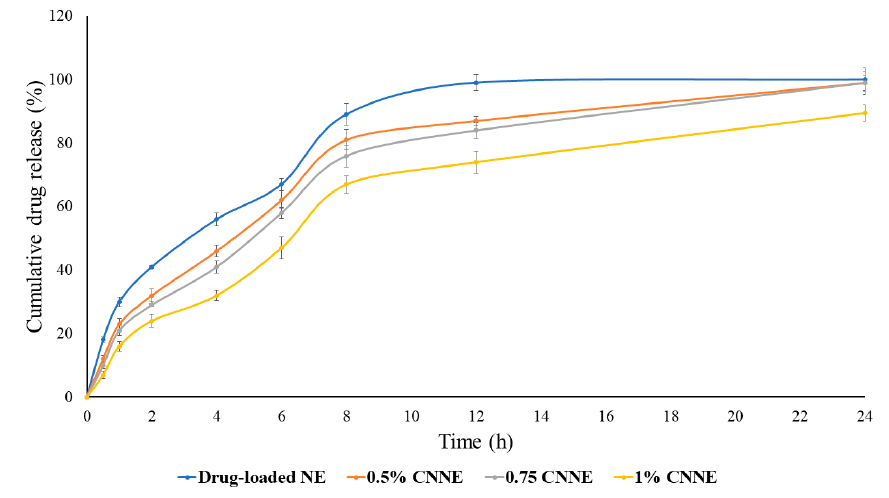
Figure 9. in vitro release profile of drug-loaded NE and chitosan coated NE Figure 9. In vitro release profile of drug-loaded NE and chitosan coated NE formulations.